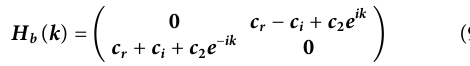
Figure 3C. NHSE effect becomes stronger in the sense that eigenmodes experience stronger localization at the left boundary, as shown in Figure 3F.